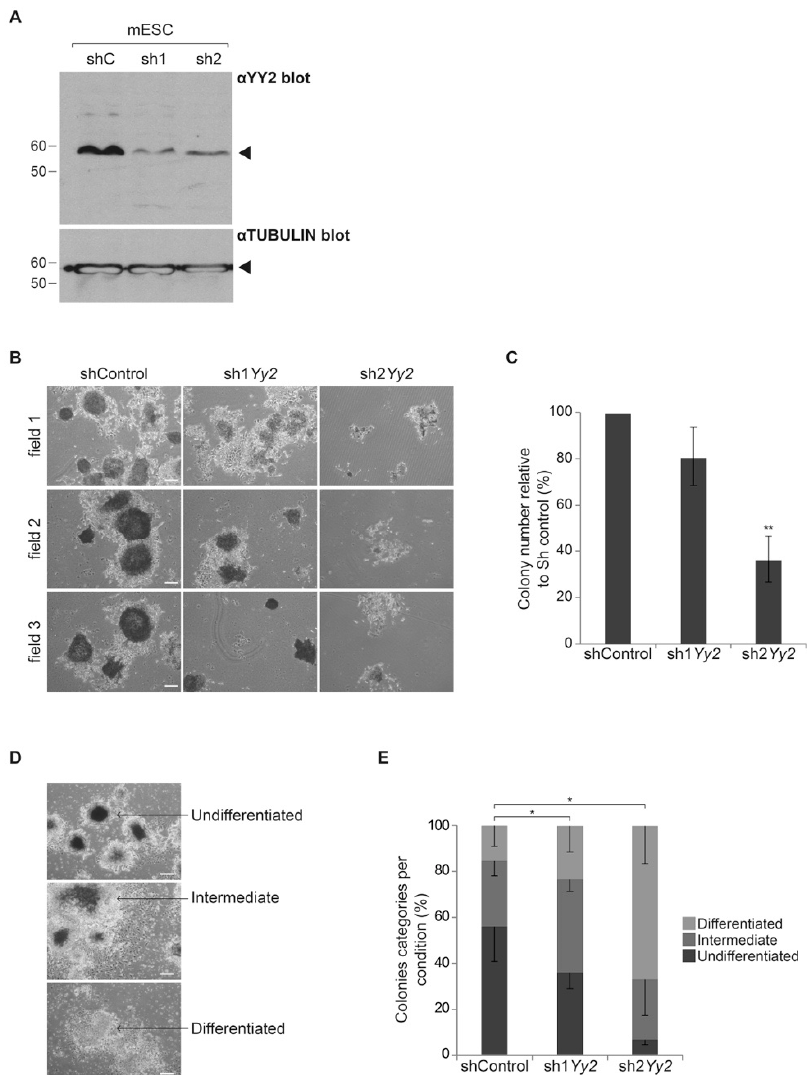
Figure 3. Attenuation of Yy2 levels impacts on colony formation capacity in mESC. ( A ) Western blot to detect YY2 (Top) or TUBULIN (Bottom) in cell lysates of mESC transfected with plasmids that express either control shRNAs (shC) or shRNAs directed against Yy2 , sh1 Yy2 (sh1), and sh2 Yy2 (sh2). Migration of molecular weight standards is indicated to the right; detected proteins are marked with arrowheads. ( B – E ) Clonogenic colony formation assays. Equal numbers of mESC were transfected with shRNA-expressing plasmids, shControl, sh1 Yy2 , or sh Yy2 , and were selected for 7 days with hygromycin. ( B ) The resulting colonies were stained for alkaline phosphatase (AP) and photographed. Three representative fields are shown for each condition. Scale bar, 100 μ m. ( C ) Quantification of the total number of colonies obtained in ( B ). Colonies per field (10 fields) were counted; the number of colonies formed by cells expressing control shRNA was set at a 100% and the number of colonies in the presence of shRNAs directed against Yy2 was calculated accordingly. Error bars represent the standard deviation over three independent assays. ** p -value ≤ 0.01 (one sample t -test). ( D , E ) Colony morphology assessment. Quantification of colonies according to AP staining and colony morphology obtained in ( B ). Colonies were categorized as pluripotent, intermediate, and differentiated according to the examples indicated. Scale bar, 100 μ m. ( E ) Total number of colonies of cells in the shControl, sh1 Yy2 , and sh2 Yy2 conditions in a predetermined number of fields (10 fields) was counted and classified in each category. The relative percentage of each category per condition is represented as a stacked bar graph. Error bars represent the standard deviation over three independent experiments. * p -value < 0.001 (X 2 test).